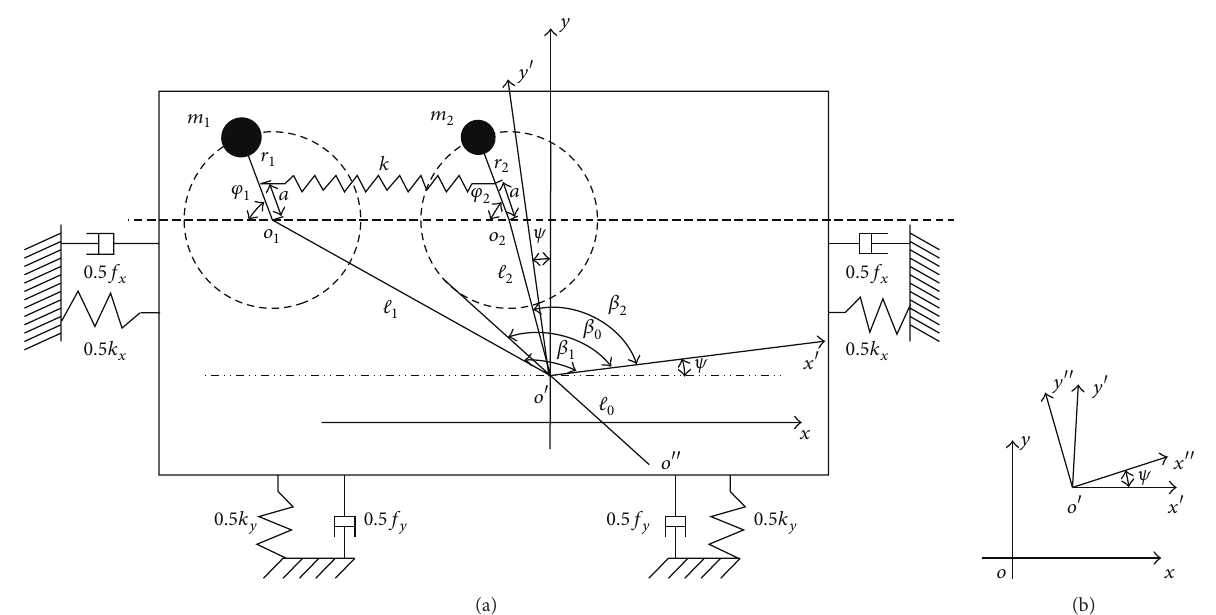
Figure 2: The model of the vibration system. (a) Dynamic model of the motors coupled with a weak spring and (b) the reference coordinate